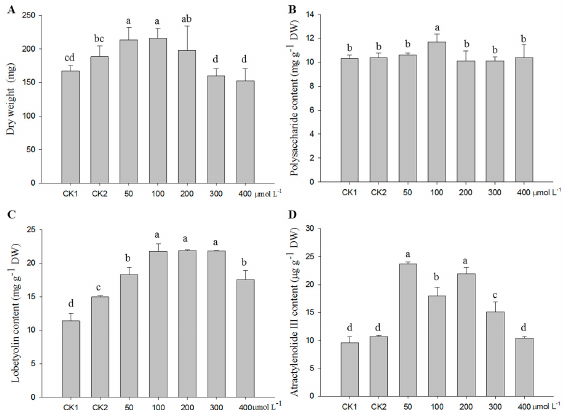
Figure 2. Effect of different concentrations of MeJA on biomass ( A ), contents of polysaccharide ( B ), lobetyolin ( C ), and atractylenolide III ( D ) in the adventitious roots of C. pilosula . CK1, blank control; CK2, solvent control. Statistically significant differences between the means were determined using Fisher’s LSD test p < 0.05) and indicated with different lowercase letters.